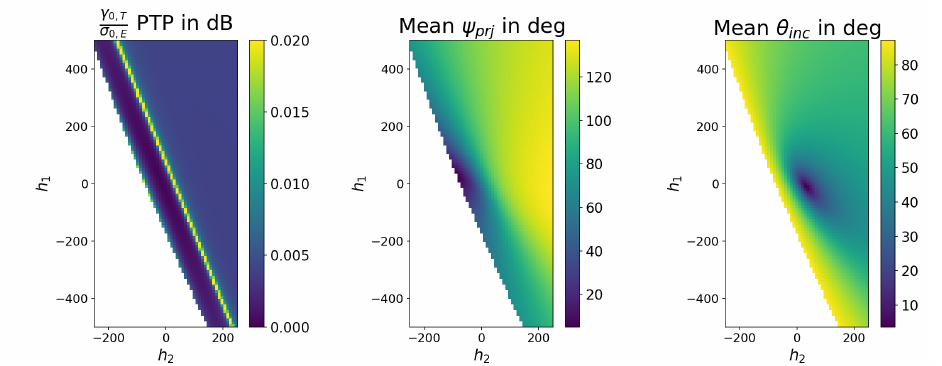
Figure 3. ( Left ) Peak-to-peak variation in γ 0, T / σ 0, E in dB, ( Middle ) Mean projection angle ( ψ prj ) and ( Right ) Mean local incidence angle ( θ inc ) as a function of h 1 and h 2 in meters of a single facet corresponding to a stack of 58 Sentinel-1 acquisitions corresponding to burst footprint IW1-0151226. The bright line in ( Left ) corresponds to ψ prj = 90 ◦ . Plots have been masked for the region corre- sponding to cos θ inc > cos − 1 ( 0.05 )